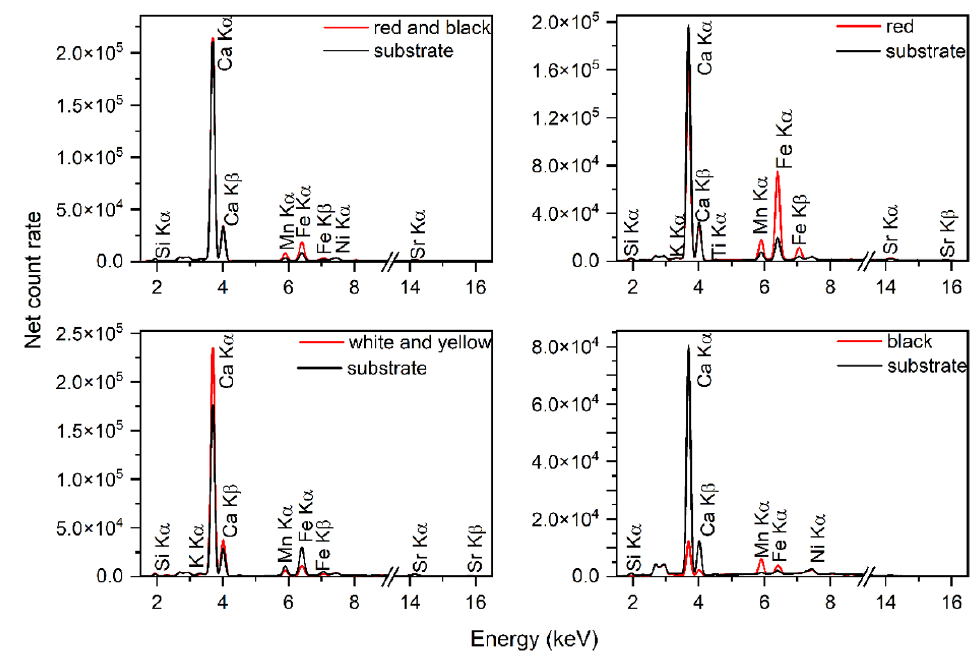
Figure 5. XRF spectra of representative samples (S1—red and black; S2—red; S3—white and yellow; S7—black).